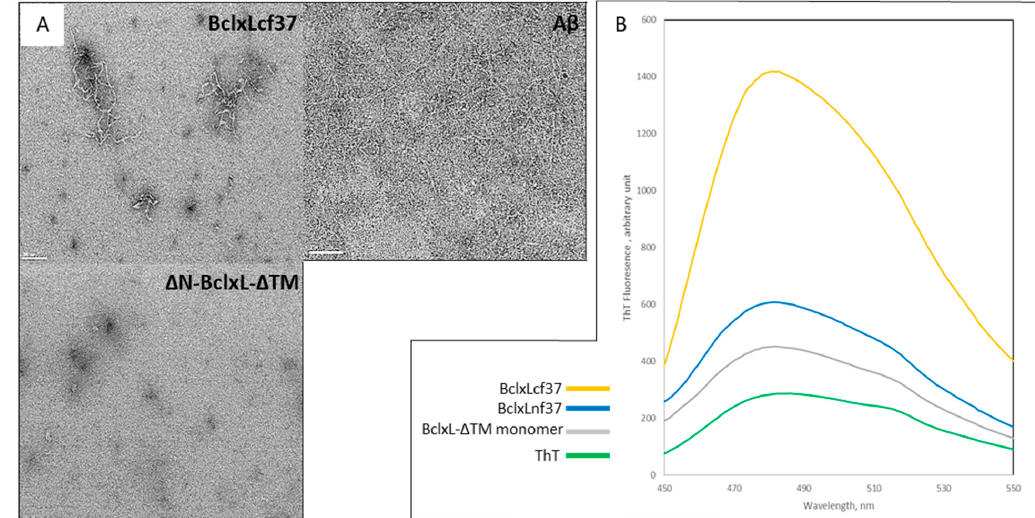
Figure 1. Trypsin-cleaved Bcl-xL forms amyloid fibers. ( A ) Transmission electron microscopy shows fibrils obtained from incubation of the cleaved Bcl-xL- Δ TM form at 37 °C (BclxLcf37); BclxLcf37 fibrils exhibit a similar shape to that of A β fibrils, and with a completely different structure from the cleaved Bcl-xL- Δ TM monomer, which appears as an amorphous structure. Scale bar represent 100µm ( B ) BclxLcf37 fibrils present a high amyloid character as determined by Thioflavin-T fluorescence measurements: yellow curve represents results of fluorescence measurements of BclxLcl37 obtained from incubation of cleaved Bcl-xL- Δ TM at 37 °C; blue curve represents results of fluorescence measurements of native and entire Bcl-xL fibers (BclxLnf37) obtained at 37 °C; gray curve represents results of fluorescence measurements of Bcl-xL- Δ TM monomer; green curve represents results of fluorescence measurements of Thioflavin-T.